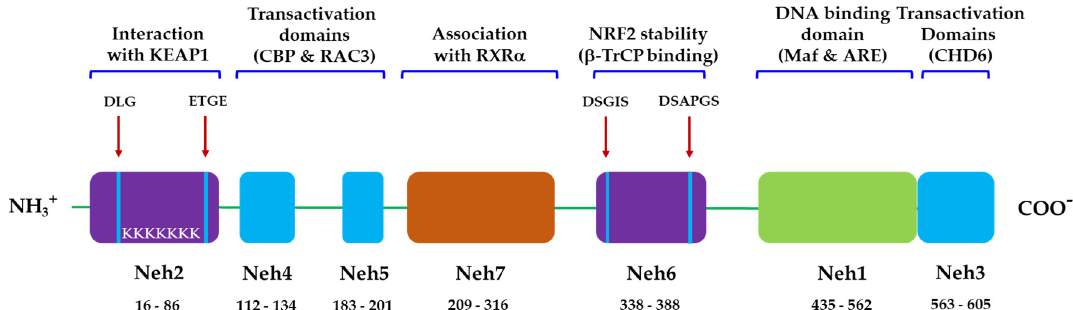
Figure 2. Domain structure of NRF2. Functional Neh domains (amino acid positions): Neh1 (16–86) is the binding site for small Maf proteins and ARE. Neh2 (435–562), the binding site for Keap1 with low-affinity DLG and the high affinity ETGE motifs. Neh3 (653–605), Neh4 (112–134), and Neh5 (183–201) are transactivation domains for NRF2 (CHD6, CBP, and RAC3). Neh6 (338–388) is a serine-rich domain that negatively regulates NRF2 stability by β -TrCP interaction with DSGIS and DSAPGS motifs. Neh7 (209–316) interacts with RXR α , a nuclear receptor responsible for the suppression of the NRF2/ARE signaling pathway.